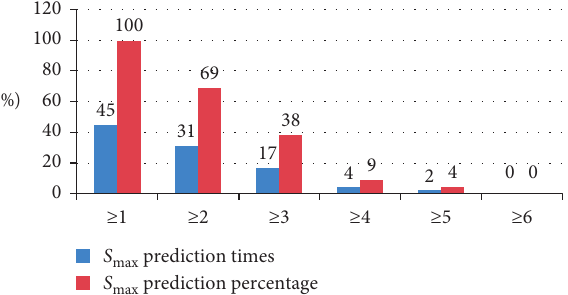
Figure 7: Distribution of S max ( Φ 42mm) during the test.